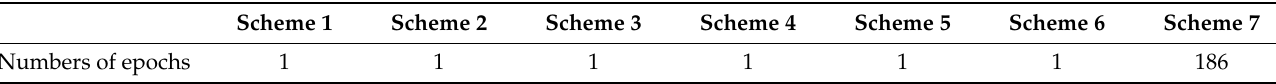
Table 2. Epoch numbers of the ambiguity initialization of several schemes for the static data.